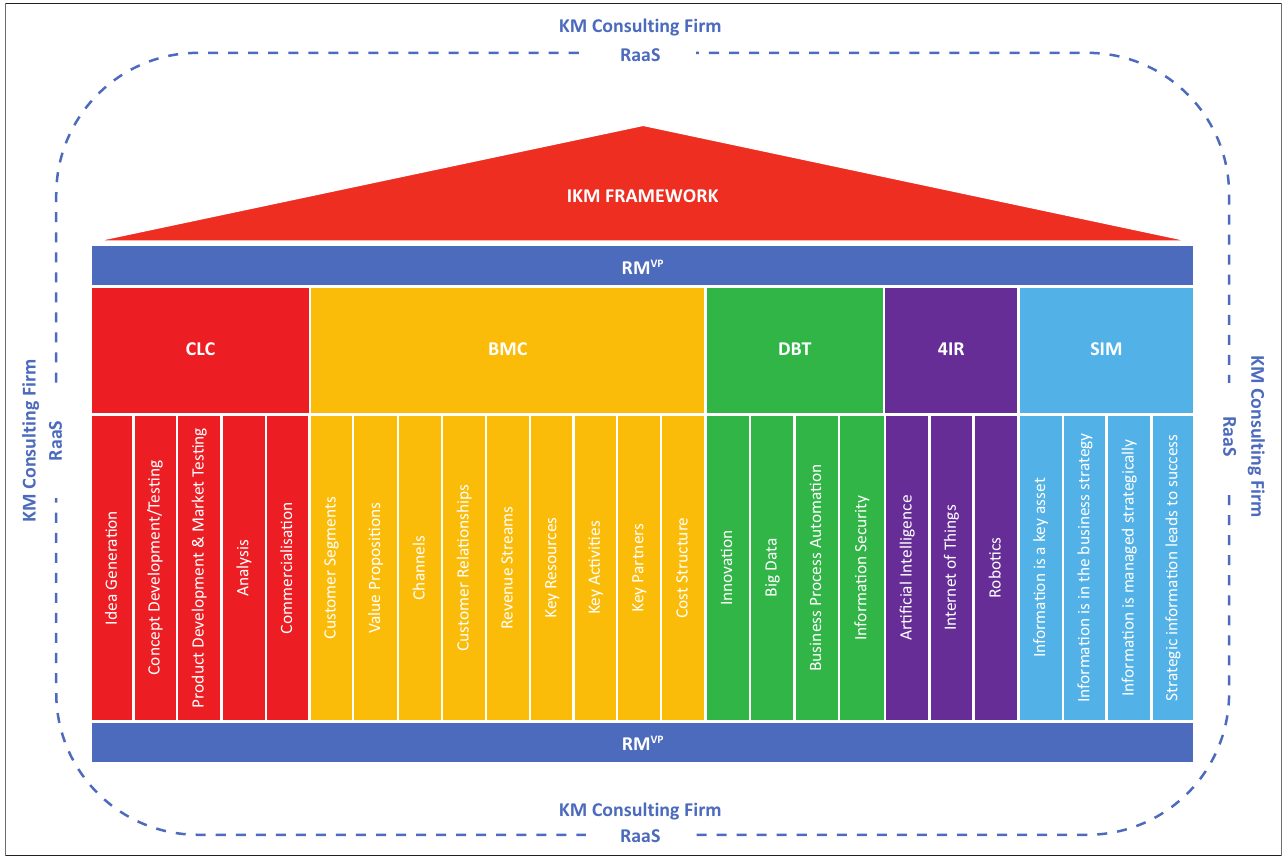
FIGURE 1: Information and knowledge management